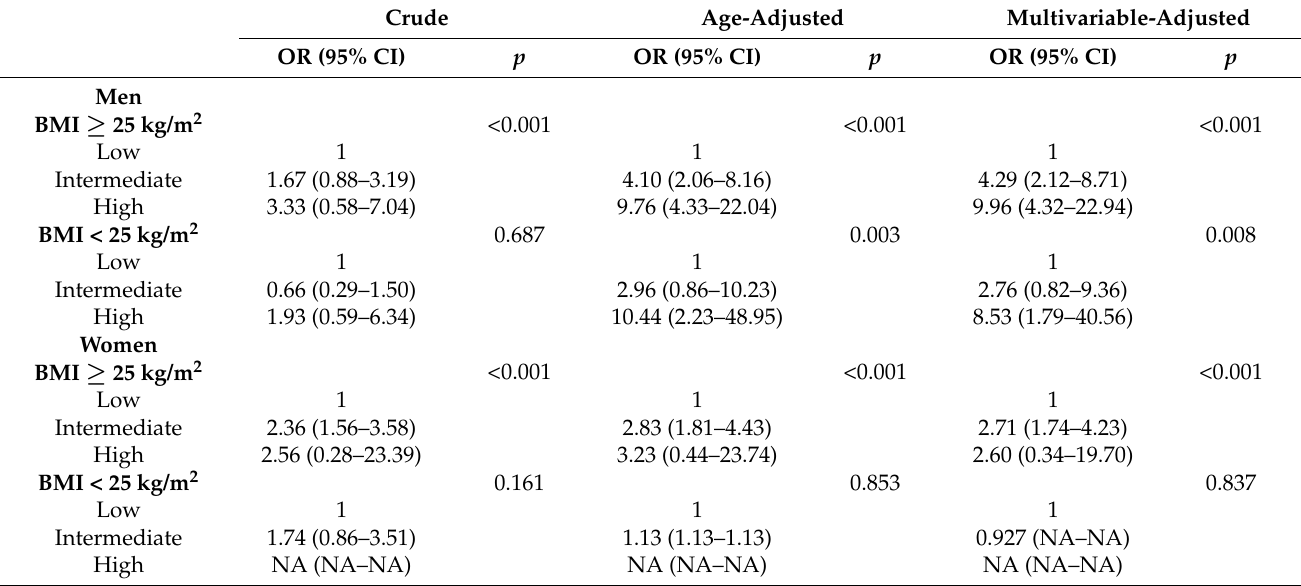
Table 3. Relationship between the risk of having OSA and NAFLD by sex and obese status. Crude Age-Adjusted